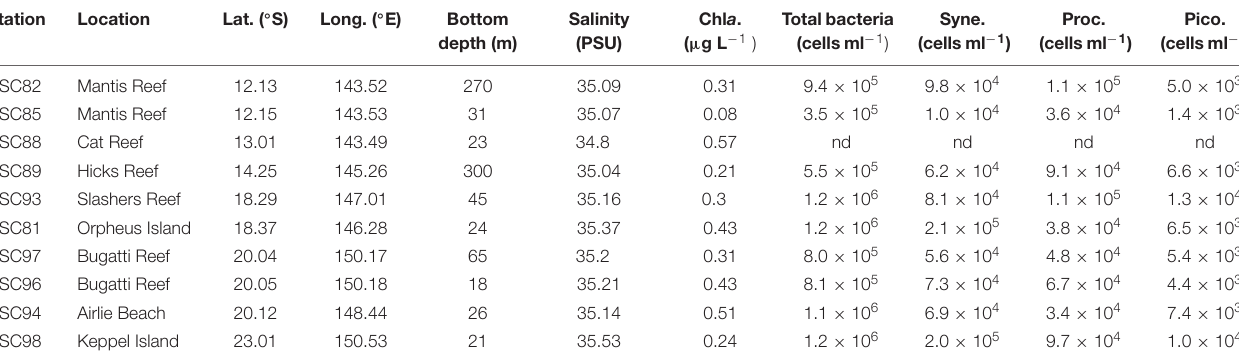
TABLE 2 | Locations of sampling stations shown in Figure 1 with environmental and contextual meta-data, including: salinity, chlorophyll a (Chl a .), and cell counts determined by flow cytometry for total bacteria, Synechococcus (Syne.), Prochlorococcus (Proc.), and picoeukaryote (Pico.) populations. Station Location Lat. ( ◦ S) Long. ( ◦ E) Bottom depth